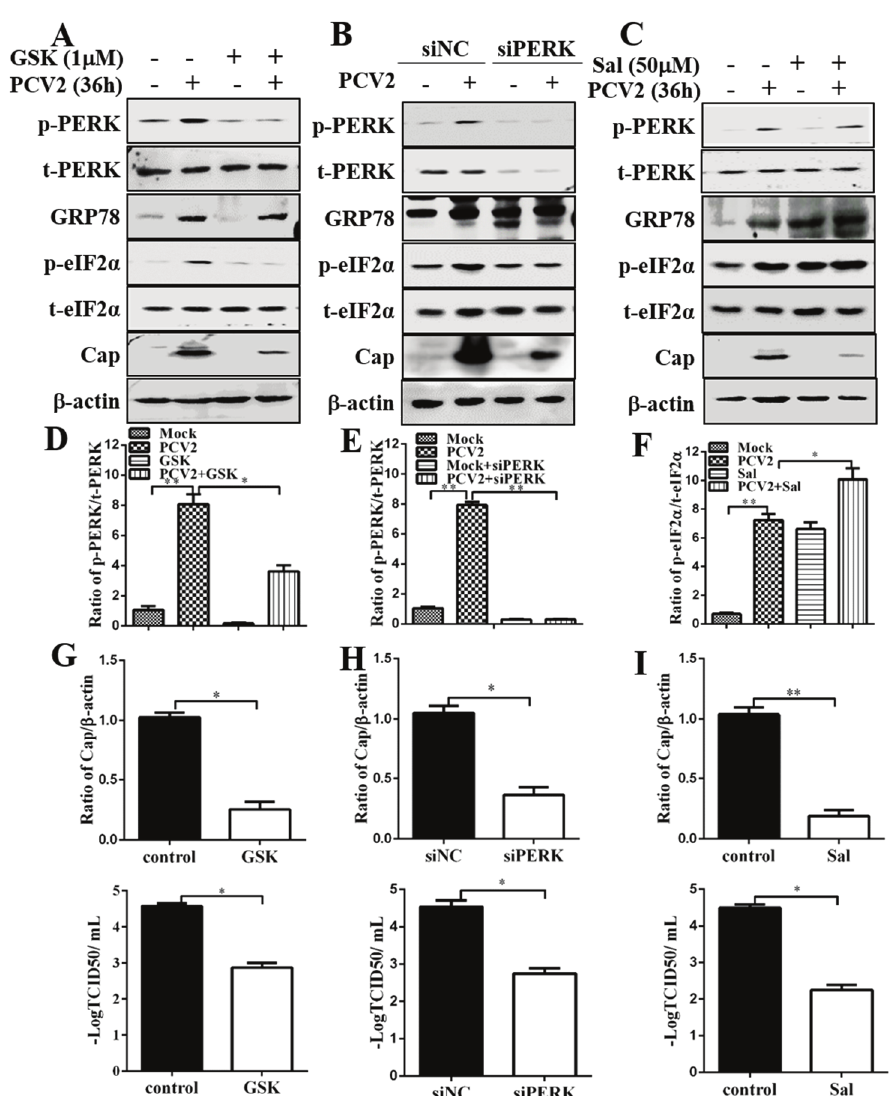
Figure 3. Inhibition of PERK by GSK2606414 or by RNA interference and attenuation of eIF2 α dephosphorylation by salubrinal reduced porcine circovirus 2 replication. PK-15 cells were infected with PCV2 (MOI = 1) for 36 h in the presence of GSK2606414 (GSK, 1 μ M) or salubrinal (Sal, 50 μ M). PK-15 cells were first transfected with PERK-specific siRNA (siPERK). Scrambled RNA was used as control. After 24 h of transfection, the cells were infected with PCV2 or mock-infected for 36 h. Whole cell lysates were subjected to Western blotting. ( A – C ) Representative blots of PCV2-infected cells treated with GSK2606414, siPERK and salubrinal respectively; ( D , E ) Inhibition of PERK by GSK2606414 or siPERK (ratio of p-PERK to t-PERK); ( F ) Inhibition of eIF2 α dephosphorylation by salubrinal (ratio of p-eIF2 α to t-eIF2 α ); ( G – I ) Effects of p-PERK inhibition by GSK2606414 or RNA interference, and inhibition of eIF2 α dephosphorylation by salubrinal on viral capsid (Cap) protein expression (ratio of Cap to β -actin normalized to control cells set at 1.0, top panels) and virus titer (log TCID 50 /mL, bottom panels).